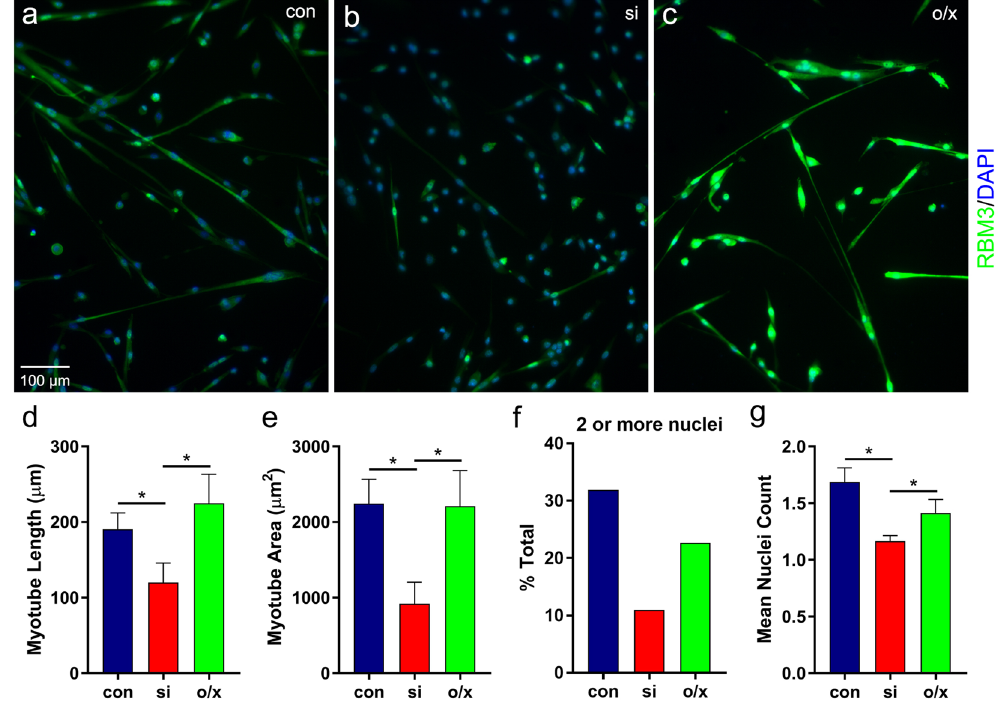
Figure 6. RBM3 regulates myotube formation in vitro . Satellite cells maintained under differentiating conditions were transfected with RBM3 siRNA (si), an EYFP-RBM3 expression construct (o/x), or subjected to mock transfection (con). ( a – c ) Images of myoblasts in the indicated RBM3 expression conditions. siRNA- mediated knockdown of RBM3 ( b ) impaired myotube formation from differentiating cells, whereas RBM3 overexpression ( c ) enhanced it. ( d–g ) Graphs summarizing the length ( d ) and area ( e ) of formed myotubes, the percentage of all cells incorporated into myotubes containing at least 2 nuclei (mean ± SEM; n = 43, 14, 17 for con, si, o/x, respectively; * p < 0.05, 1-tailed t-test) ( f ) and the mean nuclei count ( g ) of all cells in each RBM3 expression condition (n = 135, 127, 43 for con, si, o/x, respectively; * p < 0.05, 1-tailed